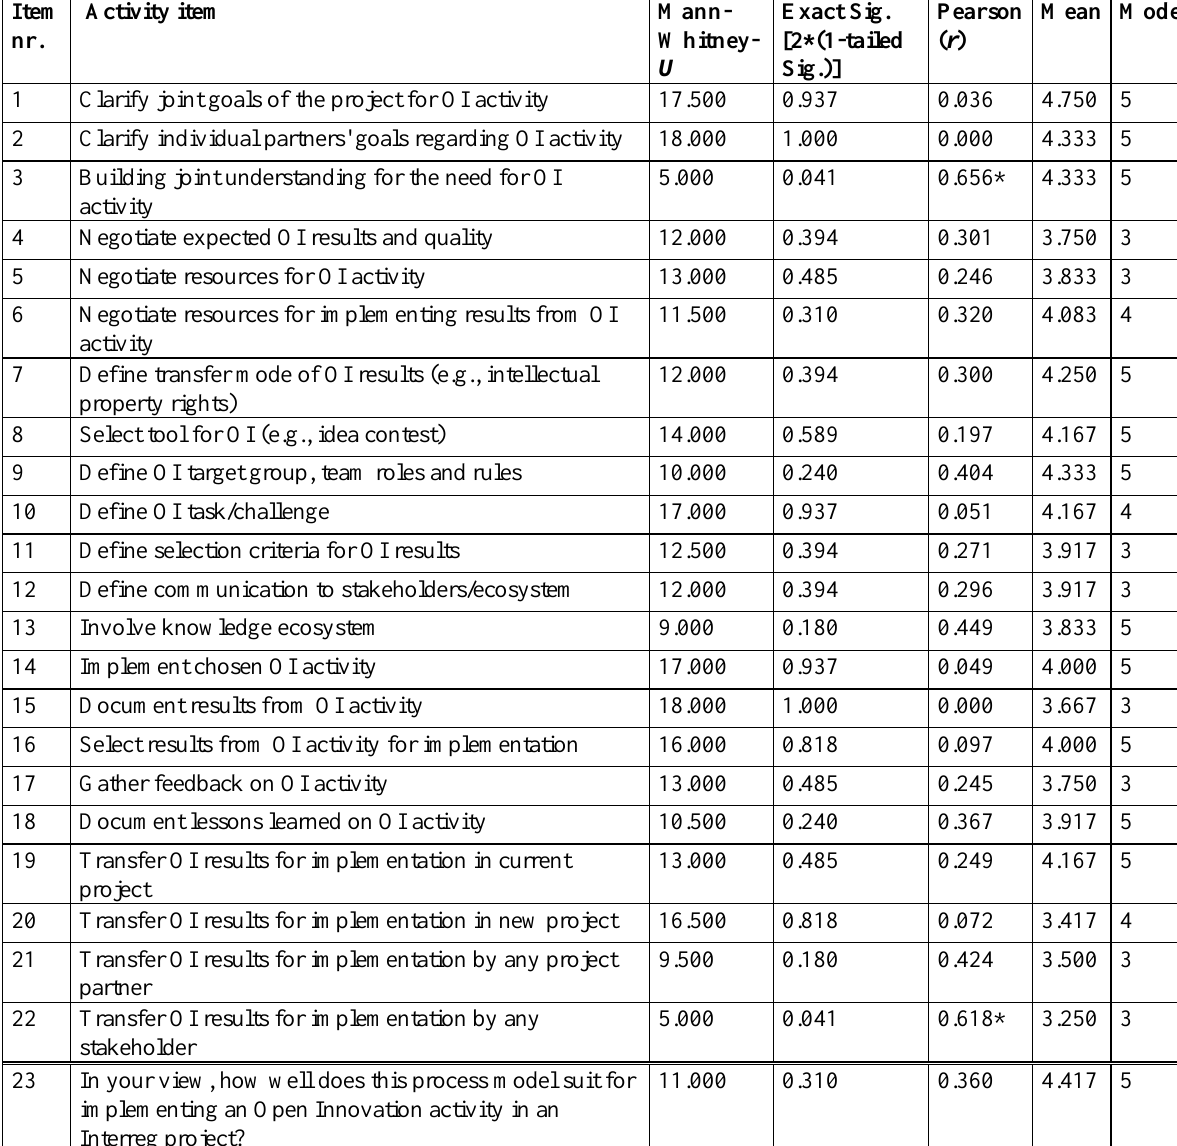
Table 3. Test results for activities and total model for differences in group 1 and 2, * p = <